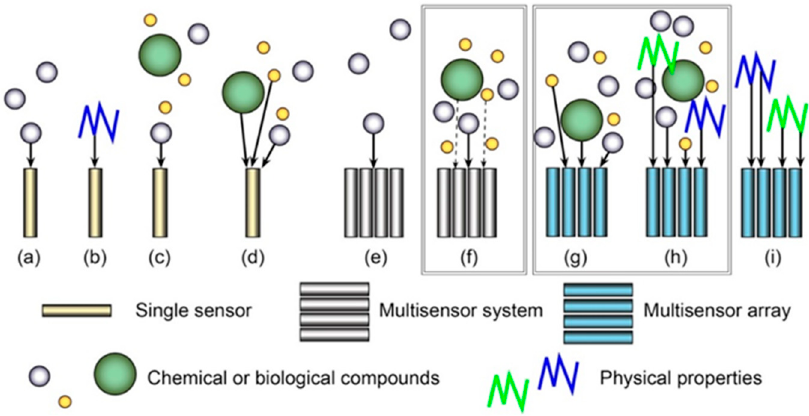
Figure 1. Types of sensors and their ensembles according to the studied characteristics of a sample. Single-sensor ( a – d ), multisensor systems ( e , f ), multisensor arrays ( g – i ) and possible targets for detection. Detailed descriptions are provided in the text.